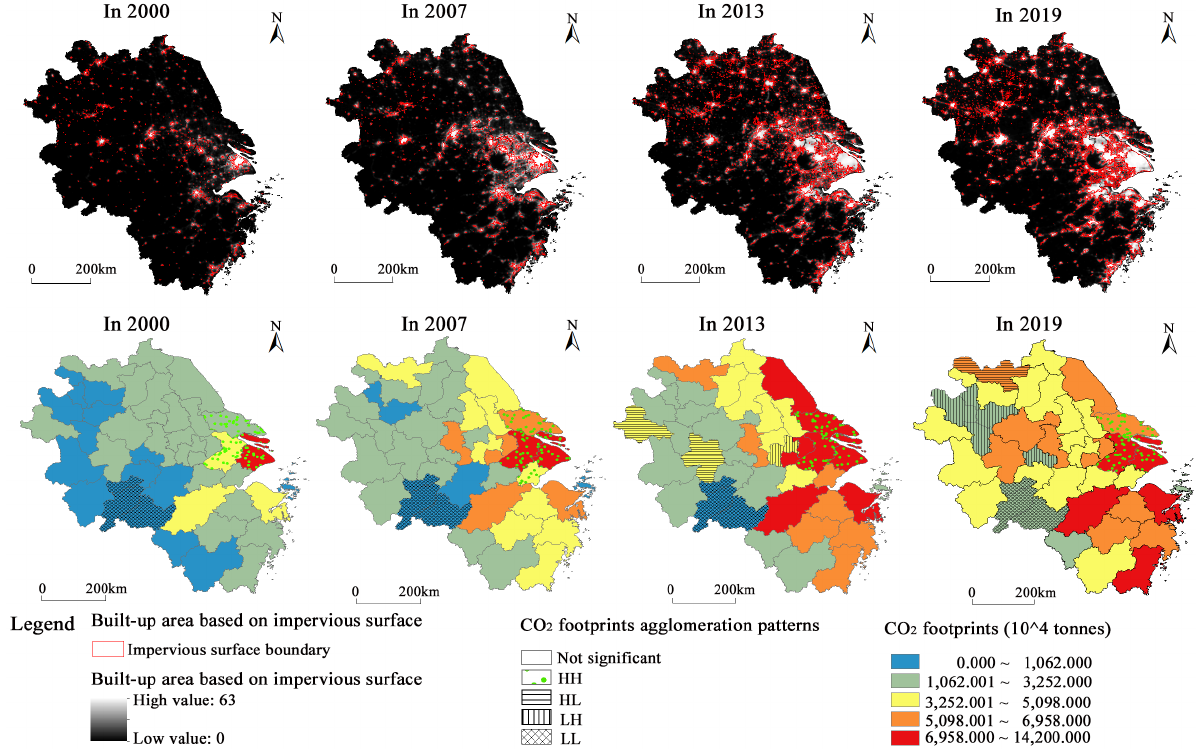
Figure 6.Figure 6. Spatial distribution of night light and CO 2 footprints in the built-up area of the